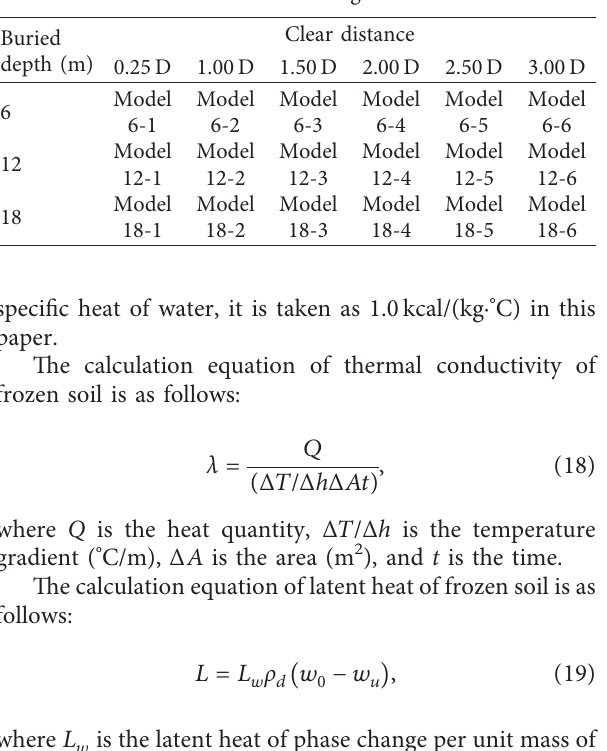
Table 1: Model design